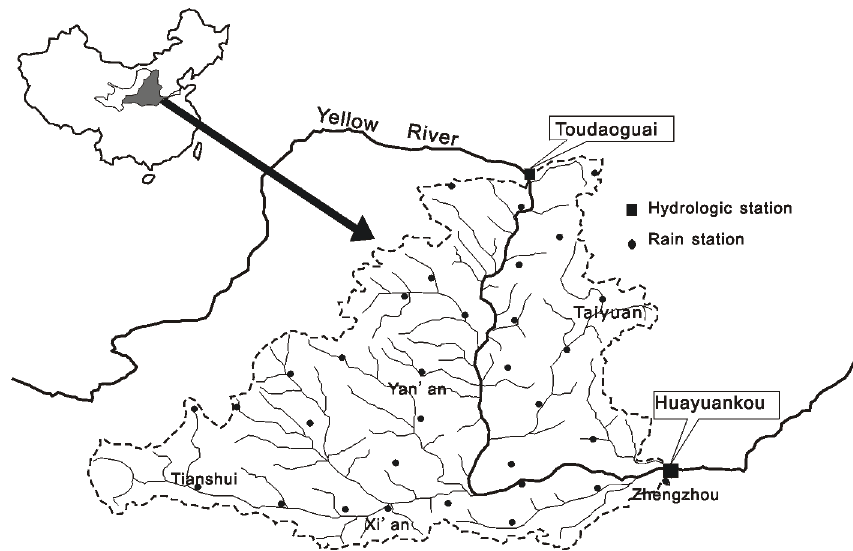
Fig. 1. Location of the study region and stations in the middle reaches of the Yellow River